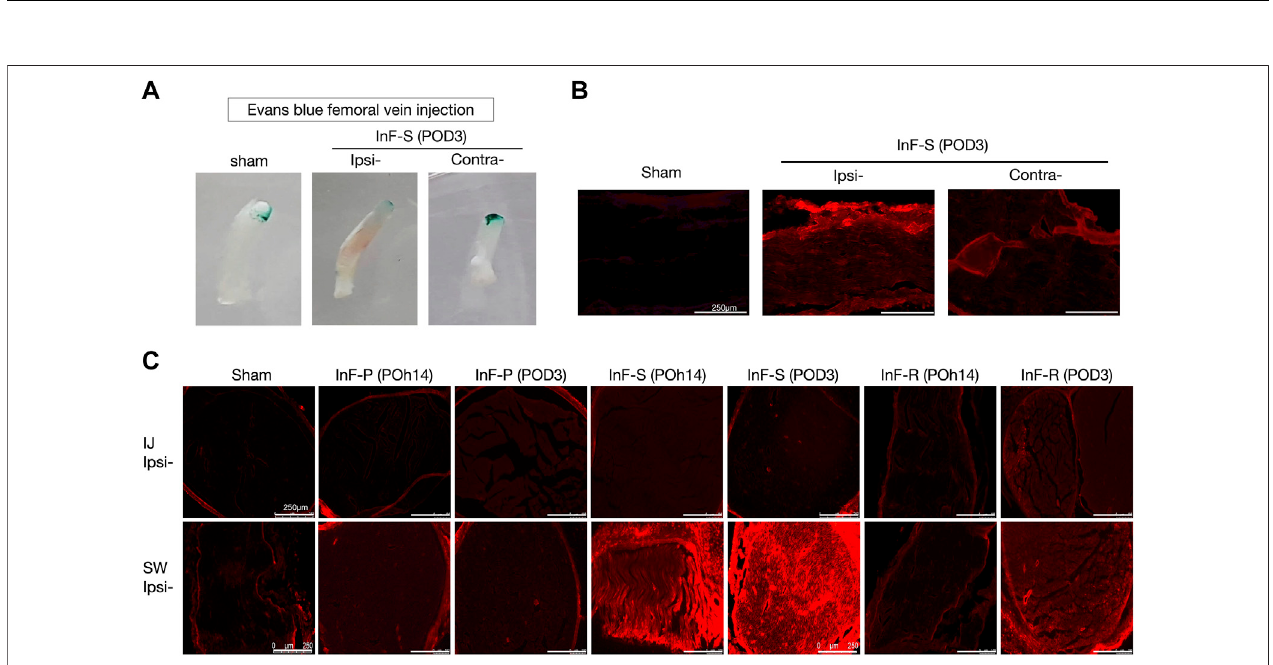
FIGURE3| Disruptionsofbloodnervebarrierintegrityintheintrafascicular(InF)injectiongroup.EBAwasadministeredviatheleftfemoralveinatadosageof1mL/ 100 g. Rats were treated with EBA for 60 min before sacri fi ce. Following normal saline perfusion, sciatic nerve was collected for histological analyses (A) Obvious damage was observed on the ipsilateral (ipsi) sciatic nerve that underwent InF-saline (s) injection. Vascular extravasation of Evans blue-Albumin (EBA) into endoneurial space of InF injection groups ’ samples via fl uorescence microscopy of (B) longitudinal-, and (C) cross-section slides.